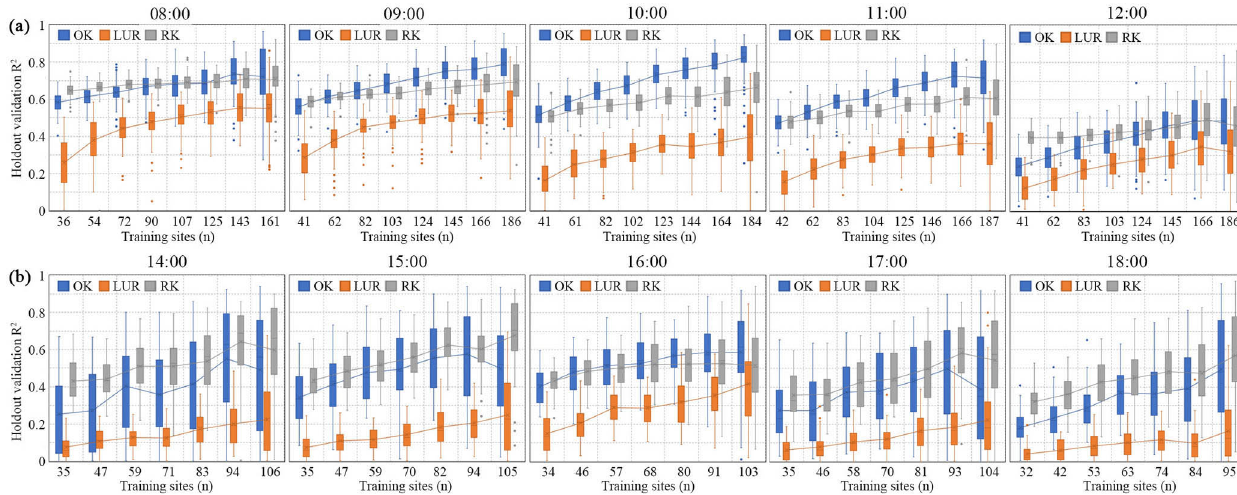
Figure 4. Box plots of holdout validation R 2 between the observed concentration and predicted concentration of PM 2 . 5 for OK, LUR, and RK with an increase in training sites: (a) Period 1; (b) Period 2. The boundaries of the boxes indicate the 75th percentile and 25th percentile (Q3 and Q1, respectively). The line within the box denotes the median (Q2), and the crosses denote the averages. The error bars above and below indicate the highest datum (Q3 + 1.5IQR, IQR is the interquartile range, IQR = Q3 − Q1) and the lowest datum (Q1 − 1.5IQR), respectively. Dots above and below the error bars indicate the